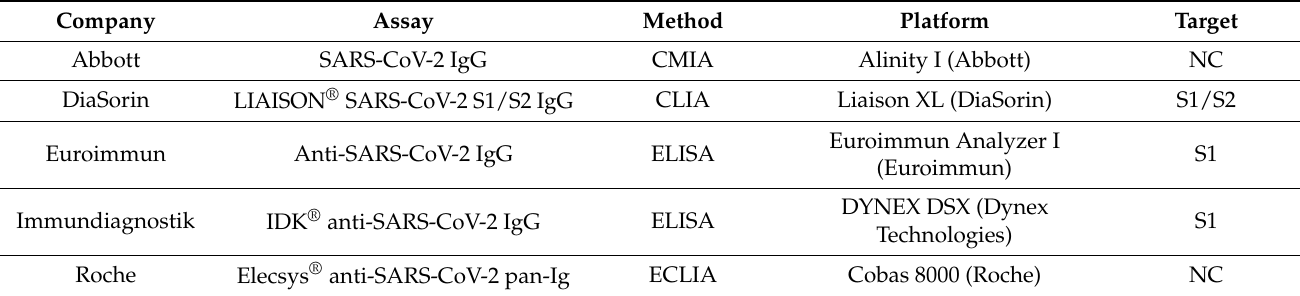
Table 1. Characteristics of evaluated commercial serological assays for detection of anti-SARS-CoV-2 antibodies.